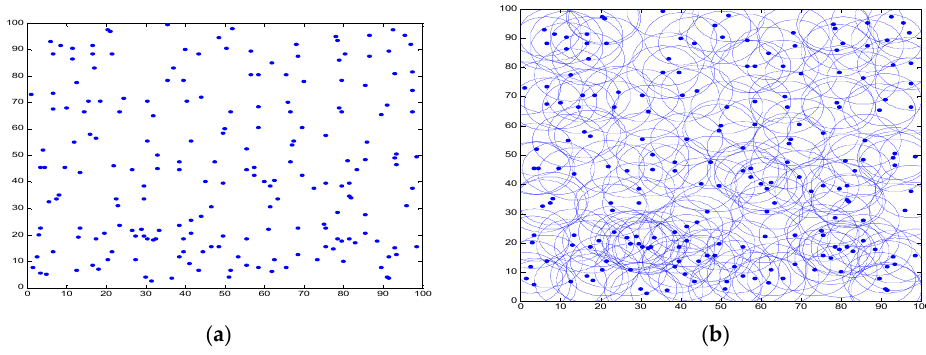
Figure 6. The initial deployment of nodes. ( a ) Nodes’ deployment; ( b ) Coverage area .